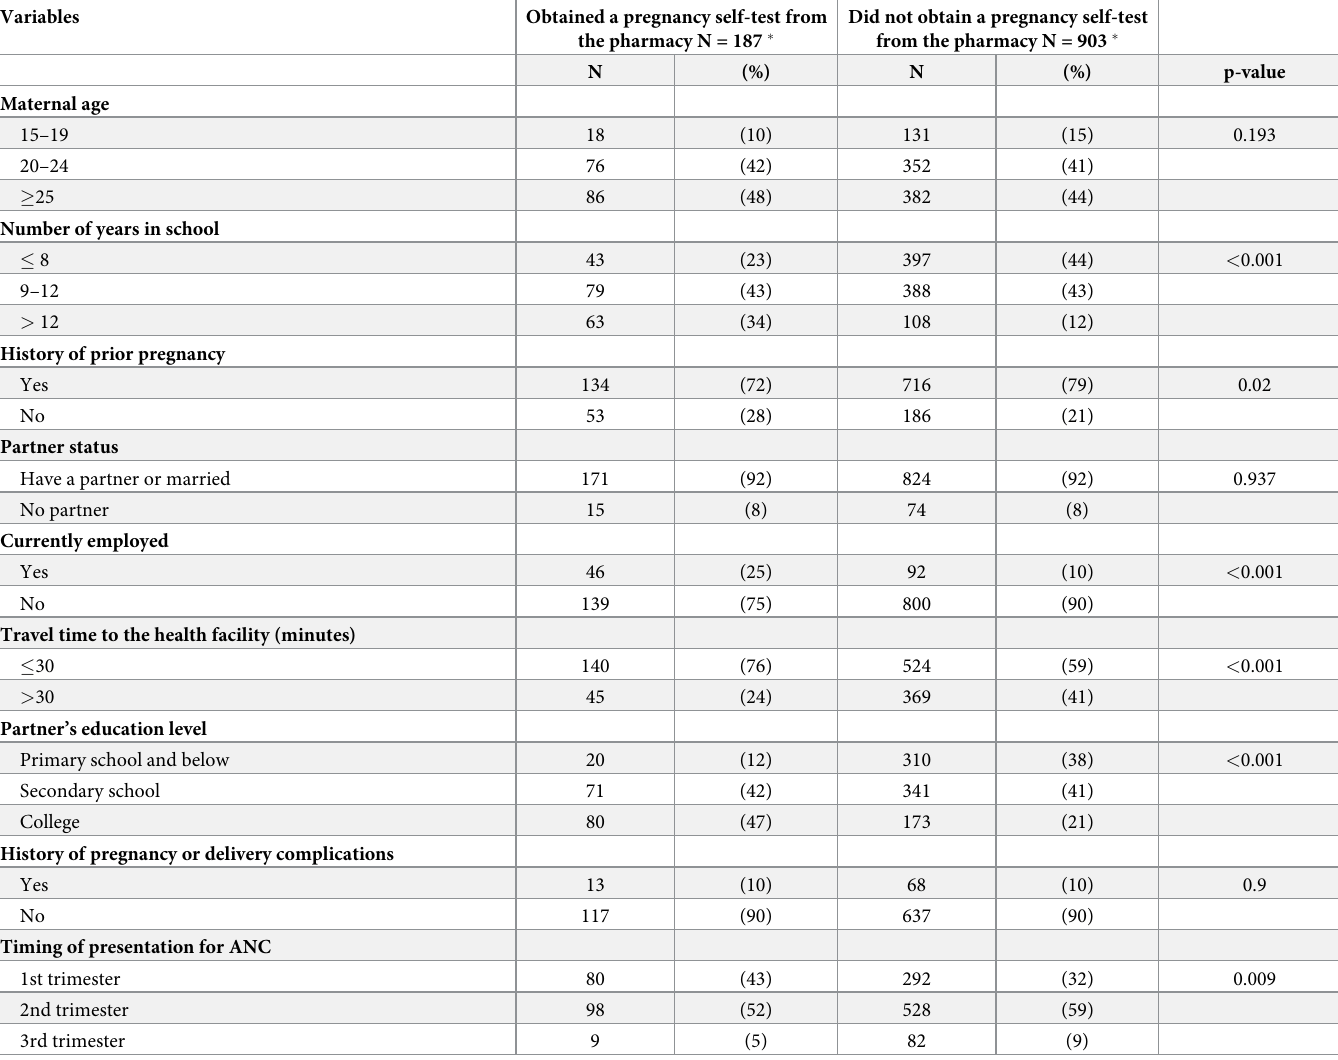
Table 1. Characteristics of pregnant women who confirmed their pregnancy with or without obtaining a pregnancy self-test from a pharmacy. Variables Obtained a pregnancy self-test from the pharmacy N = 187